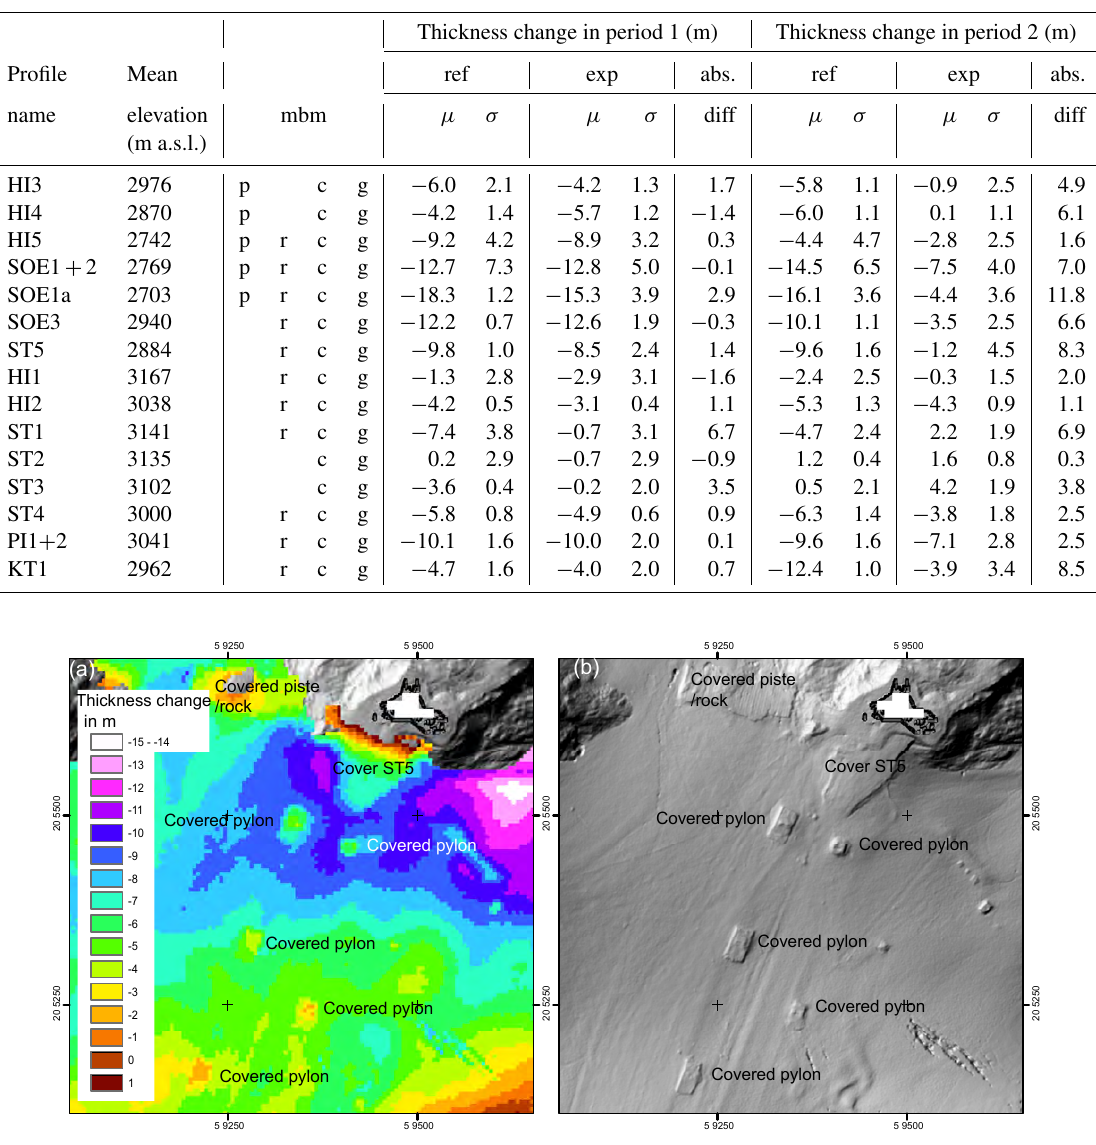
Figure 3. The thickness changes on Schaufelferner (Stubai glacier ski resort) at the location of the mass balances measures (a) on the lidar DEM hillshade of 2006 are lower than in the surroundings (b)